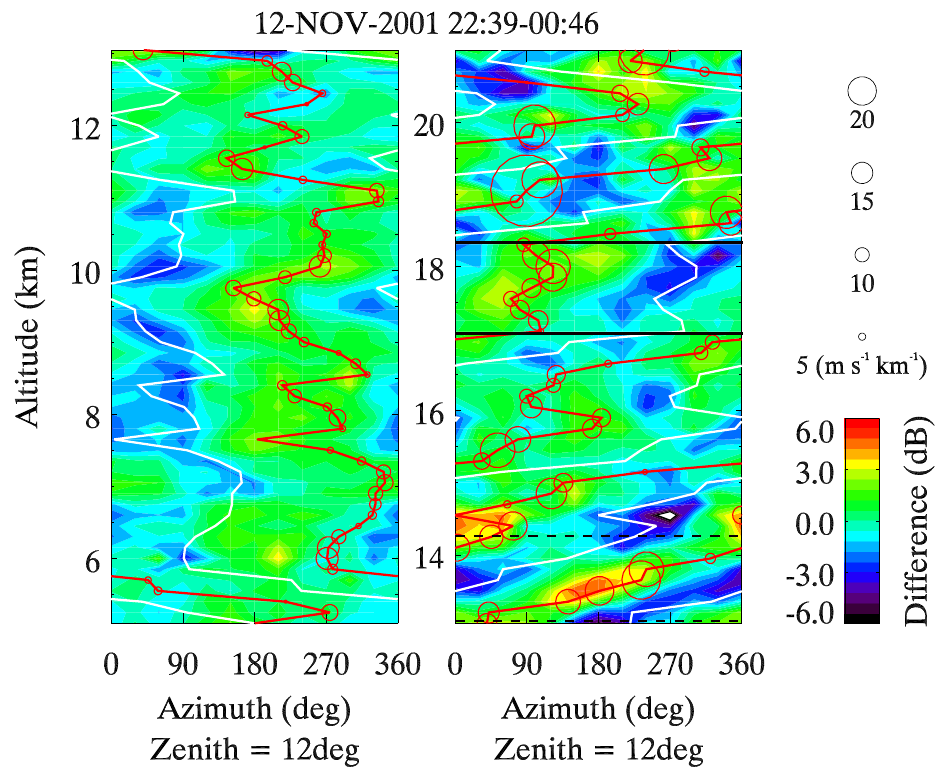
Fig. 4. Height variations of the azimuth dependence of echo power averaged from 22:39 to 00:46LT. The red and white lines indicate wind shear direction defined by S = ( − 1u/1z, − 1v/1z) and S = (1u/1z,1v/1z) , respectively. The radius of red circles indicates the wind shear magnitude. The horizontal black dotted and solid lines correspond to the analyzed ranges shown in Figs. 5a and b,